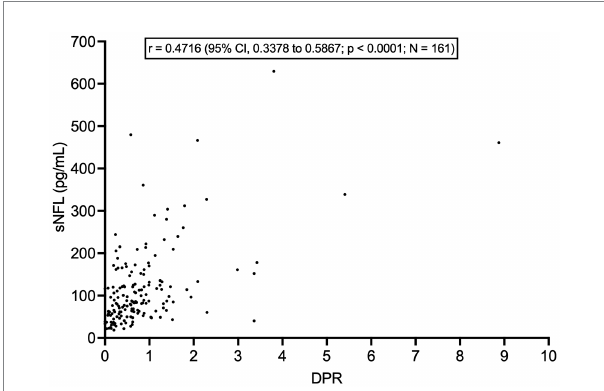
FIGURE 3 Correlation between serum NFL levels and disease progression rate. DPR, disease progression rate; CI, confidence interval; NFL, neurofilament light chain; sNFL, serum neurofilament light